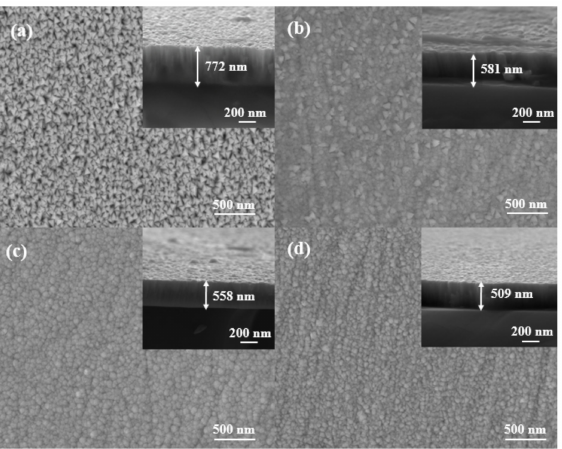
Figure 4. Surface morphology and cross-sectional images (insert) of ( a ) TiN-0.25 ( b ) TiN-0.35 ( c ) TiN- 0.45 ( d ) TiN-0.55